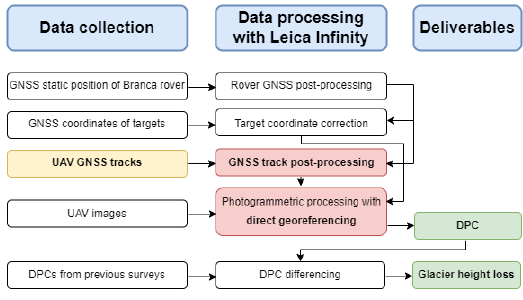
Figure 4. Processing flowchart based on UAV track post-processing and direct